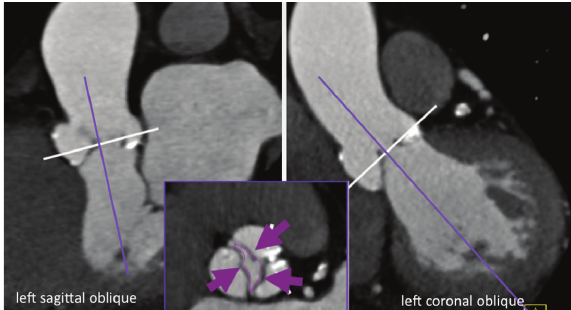
Figure 2: Aortic stenosis: Aortic valve area (AVA) sizing by CT . Using 3-multiplanar reformations (MPR), from left sagittal oblique (left) and left coronal oblique (right) views, a cross-sectional view of the aortic valve is generated ( lower mid image ). The white line indicates the plane of the cross-sectional axial oblique view in the low midimage inlay, which allows quantification of the inner aortic valve orifice area (AVA) (pink arrows). This area is traced by a digital caliper and reflects a marker for the severity of aortic stenosis ( < 1cm 2 : severe critical). Valve morphology was bicuspid (fused raphe).